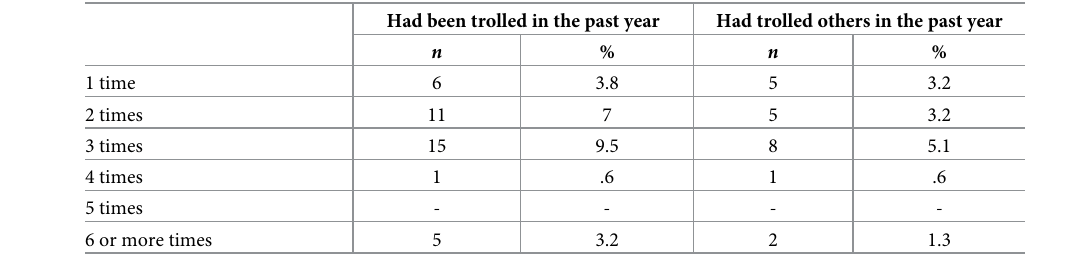
Table 1. Frequency table for trolling.